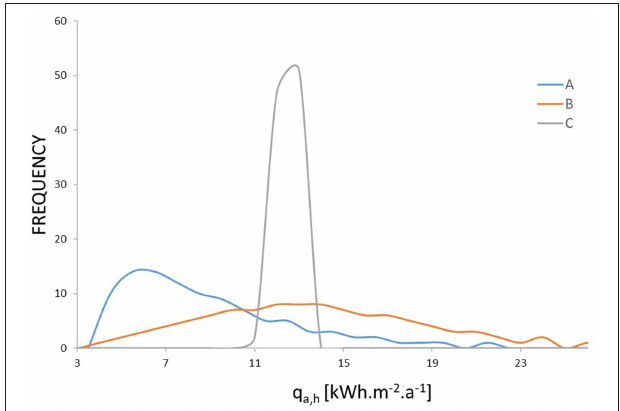
FIGURE 7 | Computed distributions of annual heating demand as a consequence of assumed input variable distributions (see Figure 8 ). Reproduced from Berger et al. (2020) with permission from C. Berger, E. Primo, D. Wolosiuk, V. Corrado, and A. Mahdavi.